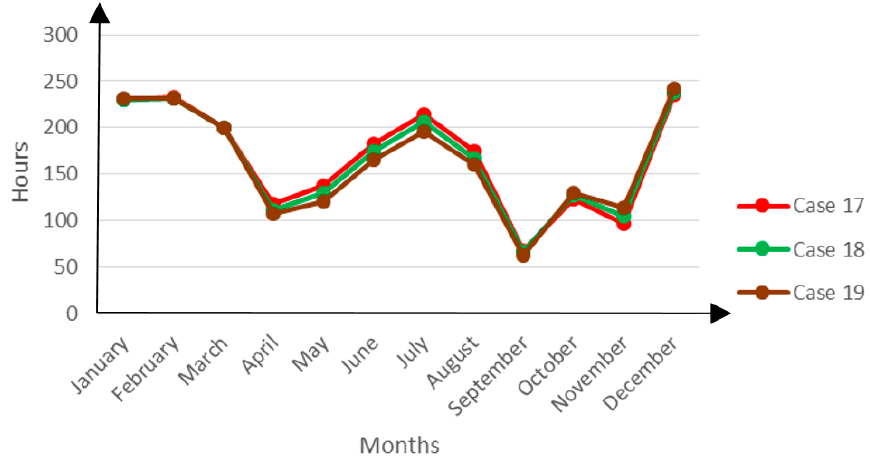
Figure 18. Discomfort hours for Cases 17, 18 and 19.